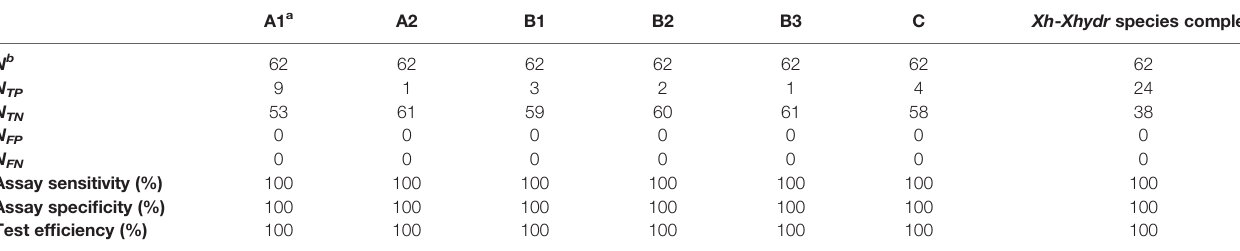
a Clade A1: X. hortorum pvs. cynarae, gardneri and vitians, clade A2: X. hortorum pv. taraxaci, clade B1: X. hortorum pv. hederae, clade B2: X. hortorum pv. carotae, clade B3: X. hortorum pv. pelargonii,cladeC: X.hydrangeae,Xh-Xhydr speciescomplex: X.hortorum – X.hydrangeae speciescomplex. b N:totalnumberofsamples;N TP :truepositivesamples;N TN :truenegatives;N FP :false positives and N FN : false negatives.